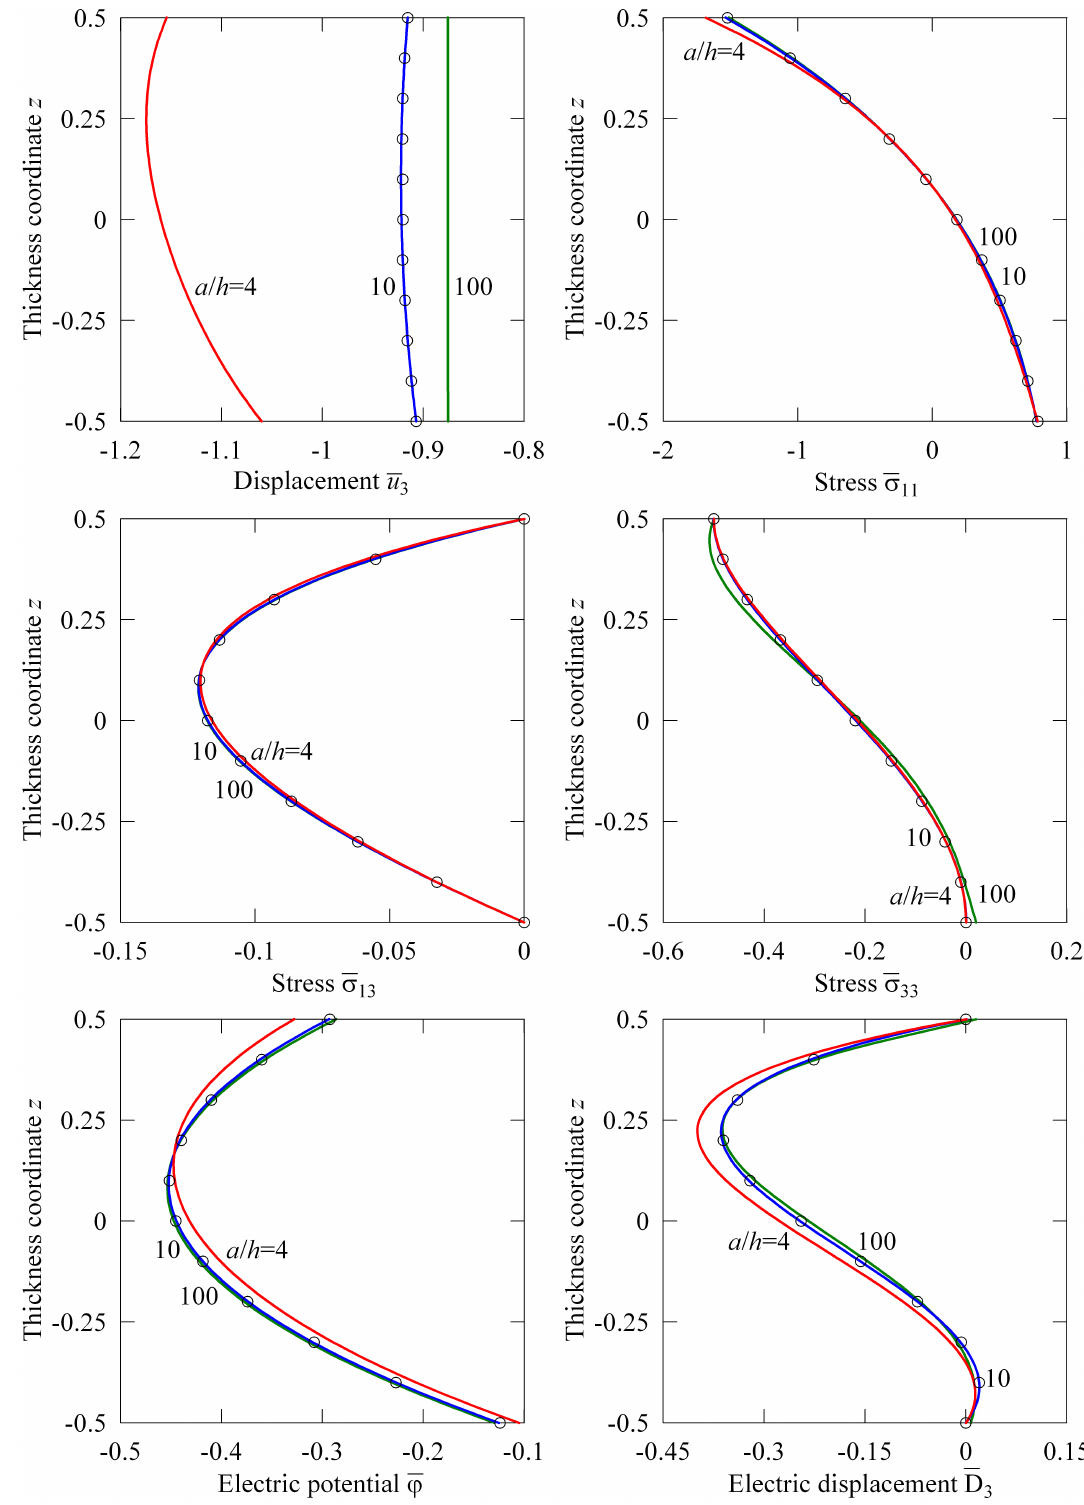
Figure 4: Through-thickness distributions of the transverse displacement, stresses, electric potential and electric displacement for a FGM piezoceramic square plate with α = 1 and N = 7 using 64 × 64 mesh; GeXSaS4 element (—) and exact solution [46] for a / h = 10 ( ∘